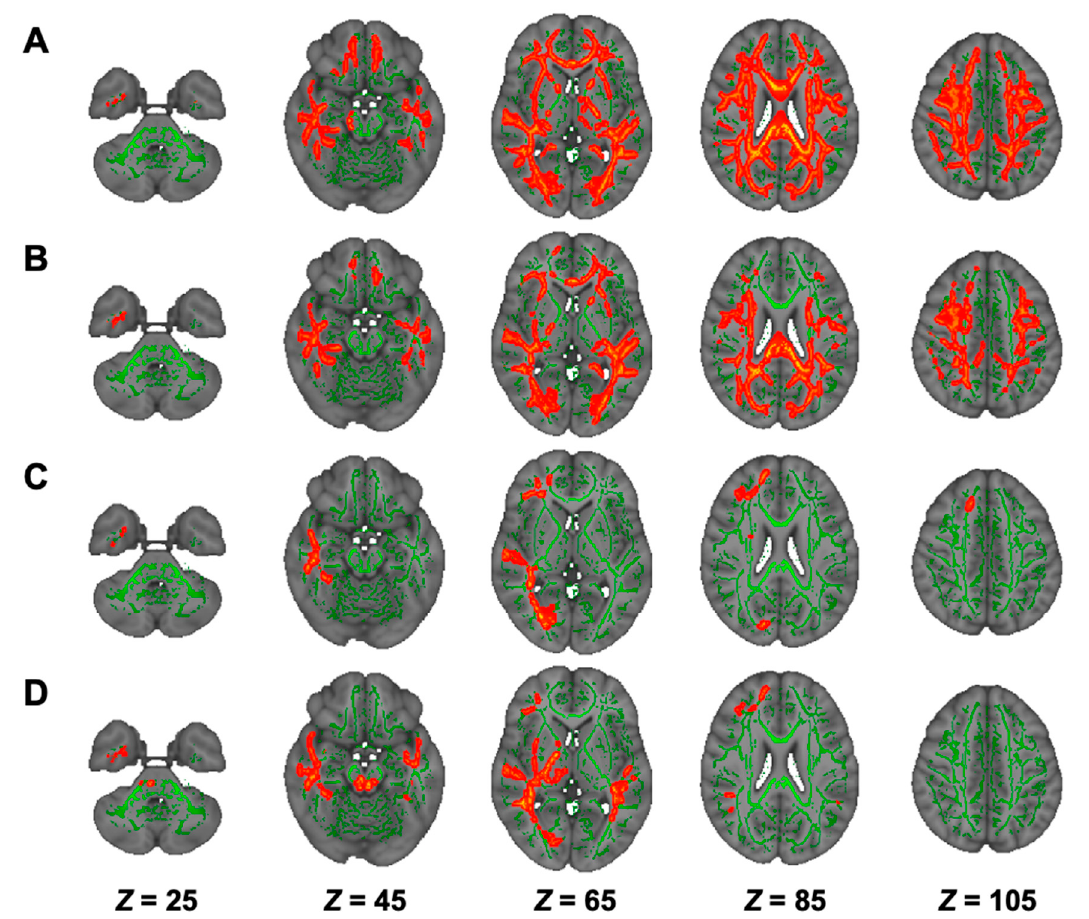
Figure 5. Comparison of TBSS of NODDI among hemodialysis patients treated with NSTLC and LTLC and healthy controls. Comparisons of ICVF ( A , B ) and ISO ( C , D ) indices among hemodialysis patients treated with NSTLC and LTLC and healthy controls are shown. TBSS analyses show that hemodialysis patients treated with NSTLC ( A ) and LTLC ( B ) have significantly lower ICVF than healthy controls ( p < 0.05). TBSS analyses show that hemodialysis patients treated with LTLC have significantly lower ISO than hemodialysis patients treated with NSTLC ( C ) and healthy controls ( D ) ( p < 0.05). The skeleton is presented in green. To aid visualization, the results are thickened using the fill script implemented in the FMRIB Software Library. ICVF, intracellular volume fraction; ISO, isotropic volume fraction; LTLC, long-term L -carnitine treatment; NODDI, neurite orientation dispersion and density imaging; NSTLC, no or short-term L -carnitine treatment; TBSS, tract-based spatial statistics.